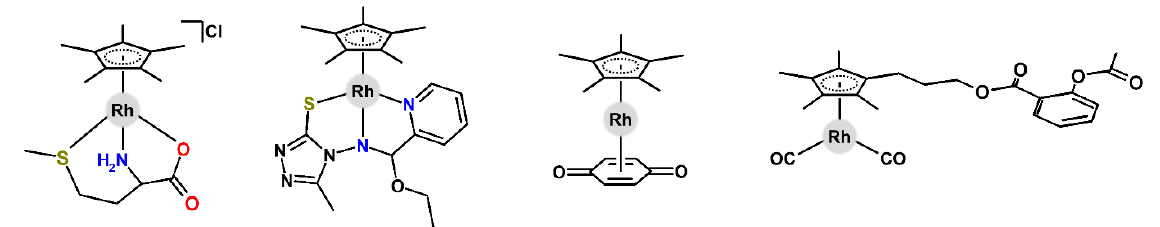
Figure 8. Structural formulas of complexes [Rh( η 5 -Cp*)(met)]Cl (left), [Rh( η 5 -Cp*)(patt 1 )]Cl (middle left), [Rh( η 5 -Cp*)( η 4 -bq para )] (middle right) and [Rh( η 5 -Cp as )(CO) 2 ] (right), with donor atoms given in blue (N), dark yellow (S) or red (O).